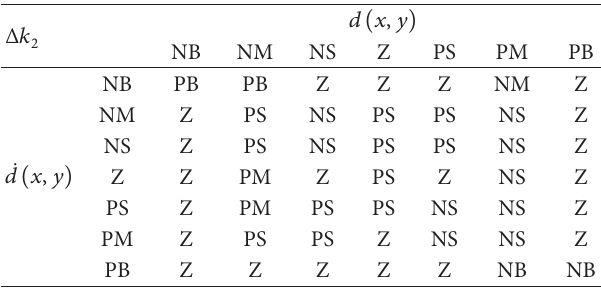
Table 1: Rule base for the fuzzy logic